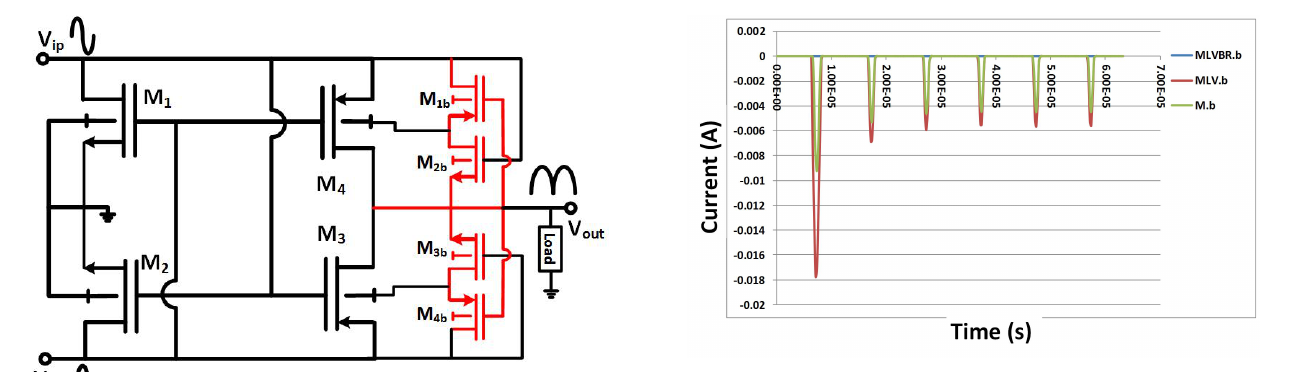
Figure 6: Transient and steady-state bulk current of CMOS rectifiers with normal and low-V th transistor with and without bulk regulation.